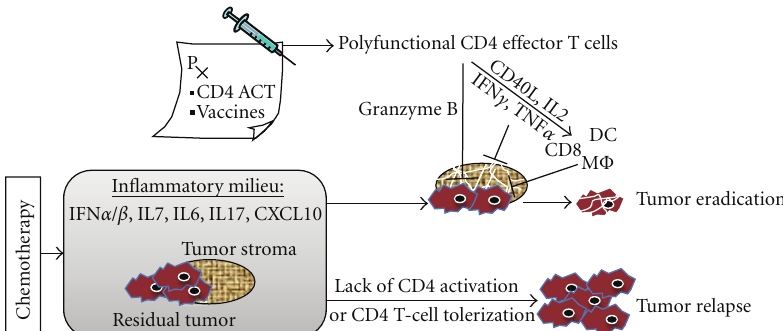
Figure 1: Hypothetical model of the mutually reinforcing e ff ect of chemotherapy and antitumor CD4+ e ff ector T cells. Chemotherapy reduces tumor burden, releases tumor antigens, and induces inflammation. In this highly immunogenic milieu created after chemotherapy, therapeutic immunological maneuvers such as adoptive cell therapy (ACT) using tumor-reactive CD4+ T cells or cancer vaccines can lead to the generation of highly activated CD4+ e ff ector T cells with polyfunctional activities. These CD4+ e ff ector T cells act as the “gatekeepers” of the overall antitumor immunity in postchemotherapy hosts, by helping the activation and function of other immune cells (CD8, DC, and macrophage) and directly attacking the tumor cells. In addition, cytokines produced by CD4+ e ff ector T cells (IFN γ and TNF α ) may also target and destroy tumor stroma and thus inhibit tumor angiogenesis. These diverse immune responses superimpose to e ff ectively eradicate residual tumors. In contrast, without properly activated CD4+ e ff ector T cells, an e ff ective host antitumor immunity may not be elicited or is not sustainable, leading to tumor persistence and eventual